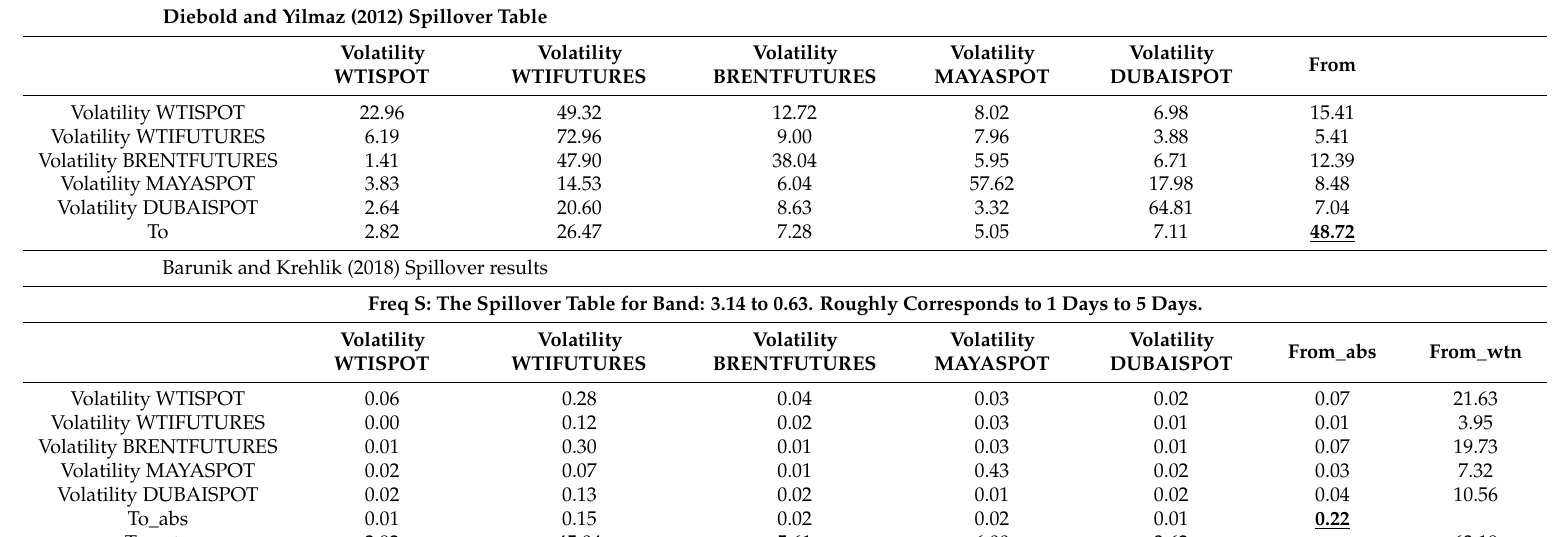
Table 4. Volatility spillover